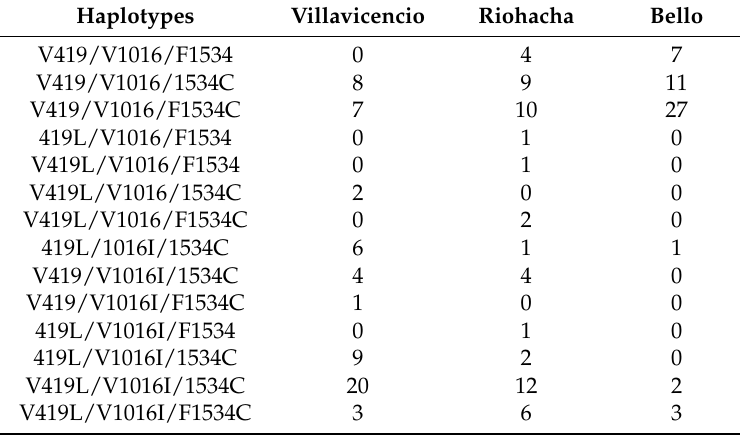
Table 4. Haplotypes observed in Aedes aegypti mosquitoes populations from Villavicencio, Riohacha and Bello.